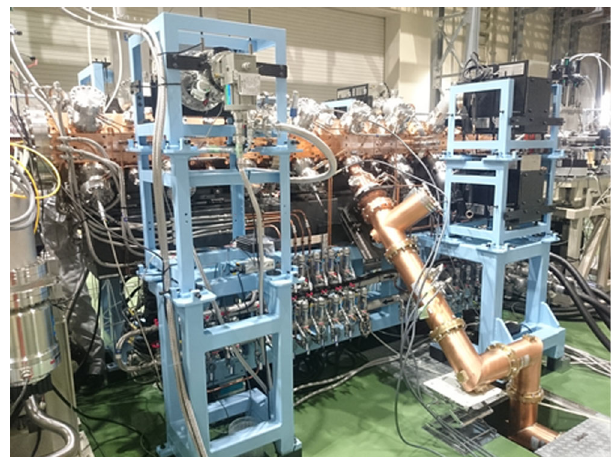
FIG. 2. Photograph of J-PARC RFQ III installed in the test stand.